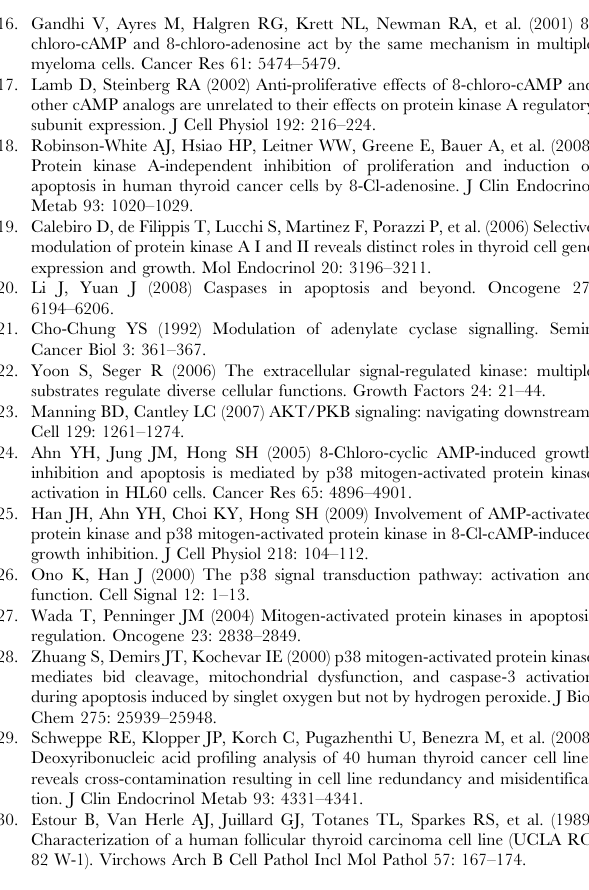
Figure S2 Effect of PKC inhibition. Cells were preincubated with a PKC inhibitor (GF109203x, 1 m M) for 1 h before addition of 8-Cl-cAMP (100 m M) for 72 h. Cell viability was determined utilizing the MTT assay. (TIF) Figure S3 Early effects of 8-Cl-cAMP and PKA I- selective cAMP analogs on ERK, p38 MAPK and Akt phosphorylation. Shown are the results of the densitometric analysis of three independent Western blot experiments per condition. Data are normalized to basal levels. Differences between peak and basal values of ERK phosphorylation are statistically significant in ARO, WRO and NPA cells after stimulation with both 8-Cl-cAMP (P , 0.05, P , 0.01 and P , 0.05, respectively) and PKA I-selective analogs (P , 0.001, P , 0.05 and P , 0.05, respectively). Differences of Akt and p38 MAPK phosphorylation are not statistically